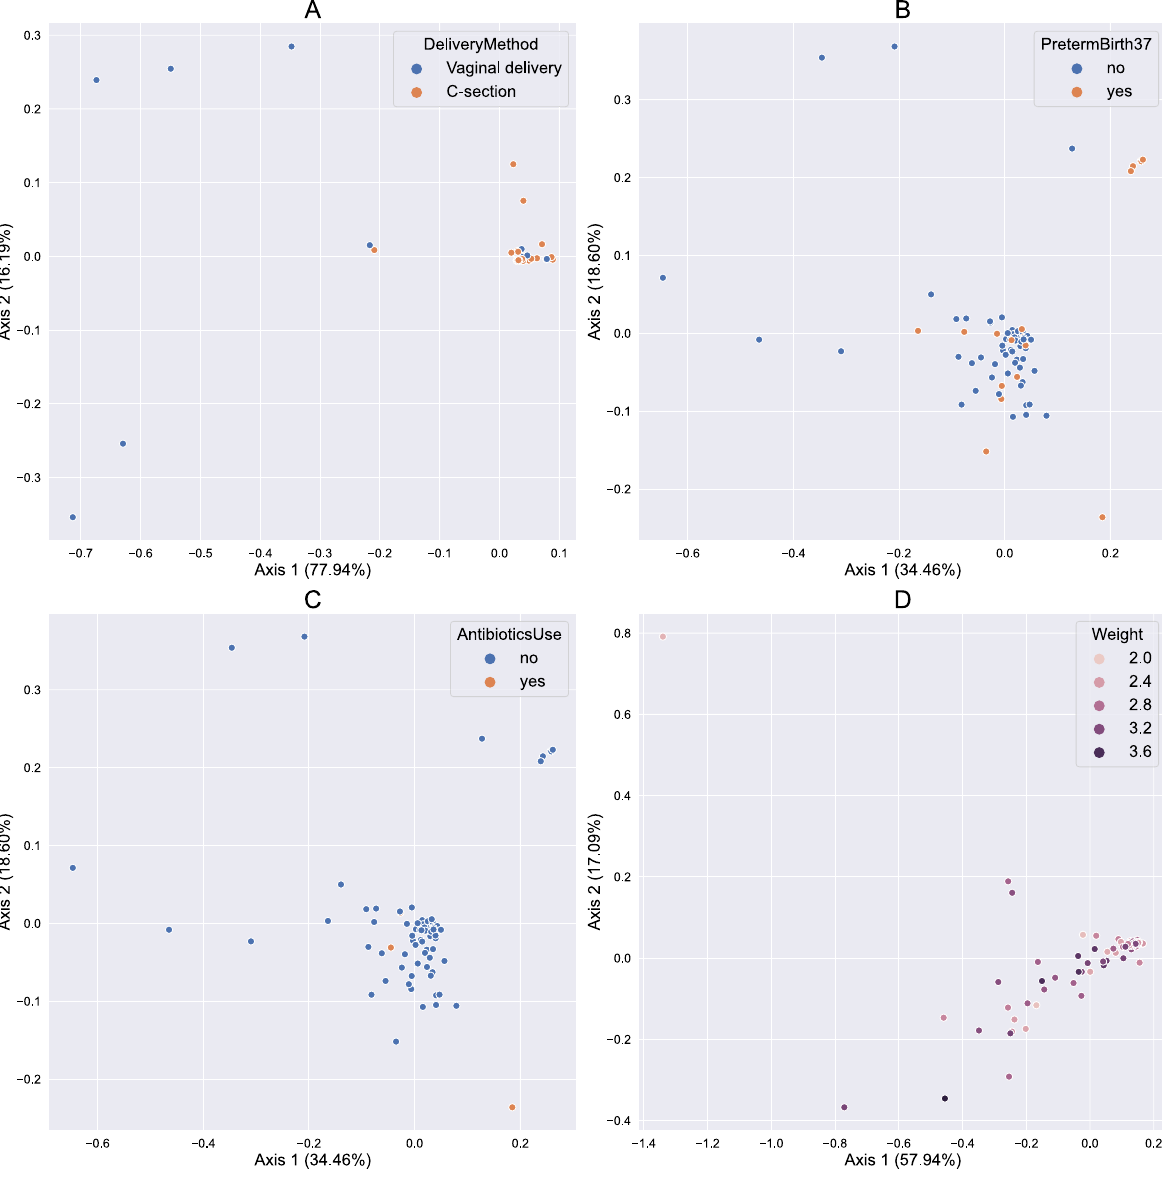
and ( D ) the umbilical cord blood